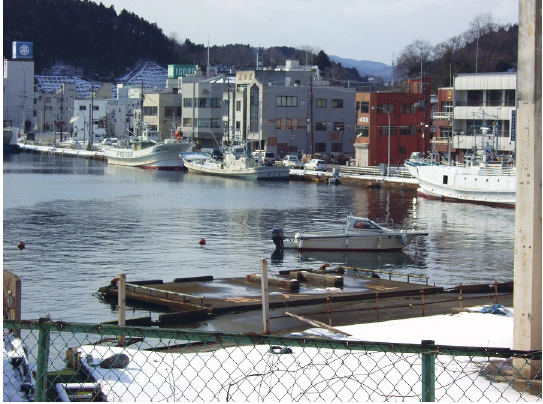
Figure 13. Damaged Kesennuma Bay